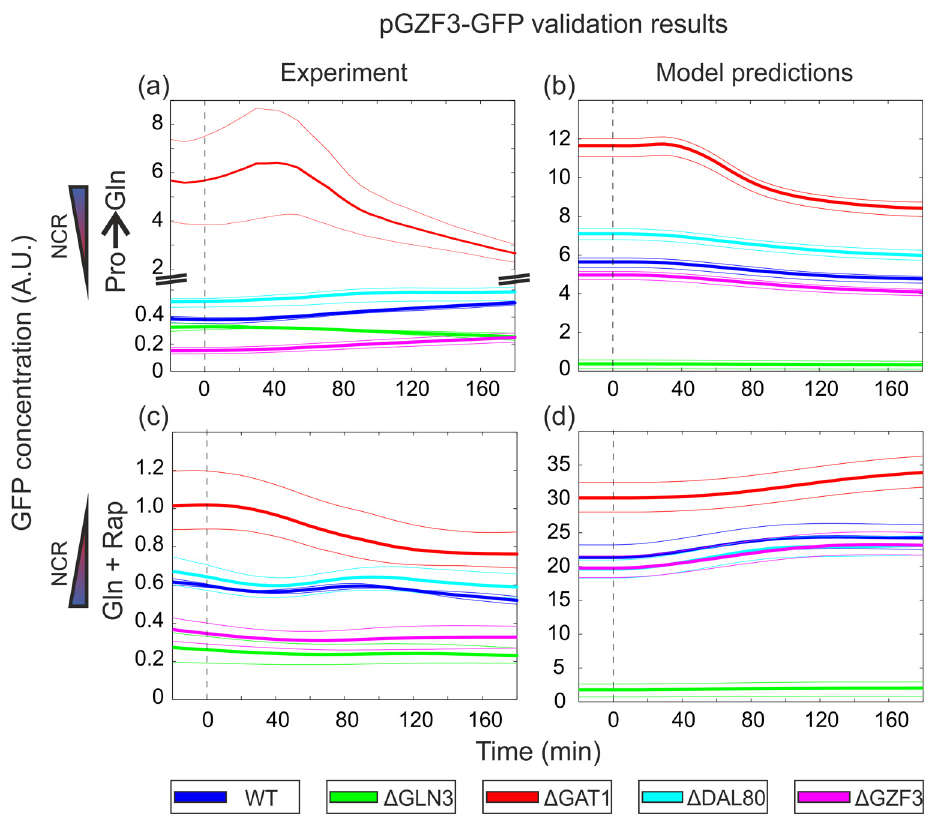
Fig 5. Data and model predictions for the yEGFP reporter driven by the GZF3 promoter (pGZF3-GFP). (a) Relative GFP concentrations for the Pro ! Gln shift. Upper and lower band limits: maximum and minimum experimentally observed values. Solid lines: mean of all biological replicates. Due to the extremely low GFP signal above background fluorescence, the small trends displayed by the curves may actually be artifacts of background normalization. Although the ordering of the responses of the various deletion strains is consistent across all replicates, the only reliably inferred response is that of the Δ gat 1 strain, in which GFP appears significantly upregulated compared to wild-type. (b) Model predictions of relative GFP concentrations for the Pro ! Gln shift, obtained from 100 randomly sampled posterior samples for the regulation function parameters. Upper and lower band limits: 80% and 20% quantiles. (c) Relative GFP concentrations for the Gln+Rap shift. Upper and lower band limits, solid lines: same as in (a). Similarly to (a), the small trends in the responses may be artifacts. However, the ordering of the responses of the various deletion strains is consistent across all replicates. (d) Model predictions of relative GFP concentrations for the Gln+Rap shift. Prediction bands obtained as in (b). Note: the Y-axis scale units are arbitrary and different between the figures on the left and right